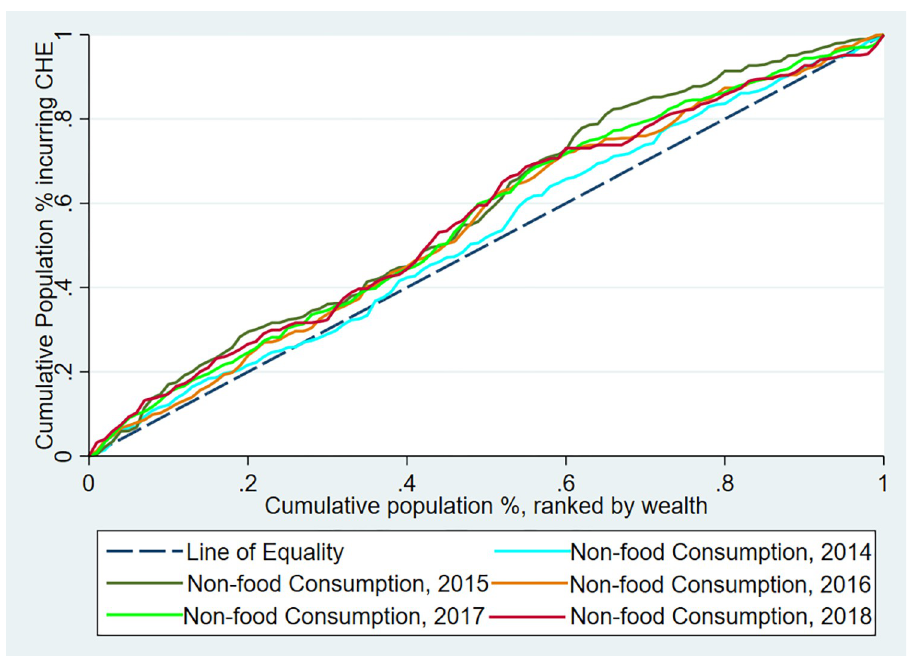
Fig 2. Concentration curve for CHE by threshold and year in Armenia—2014 to 2018 ILCS.